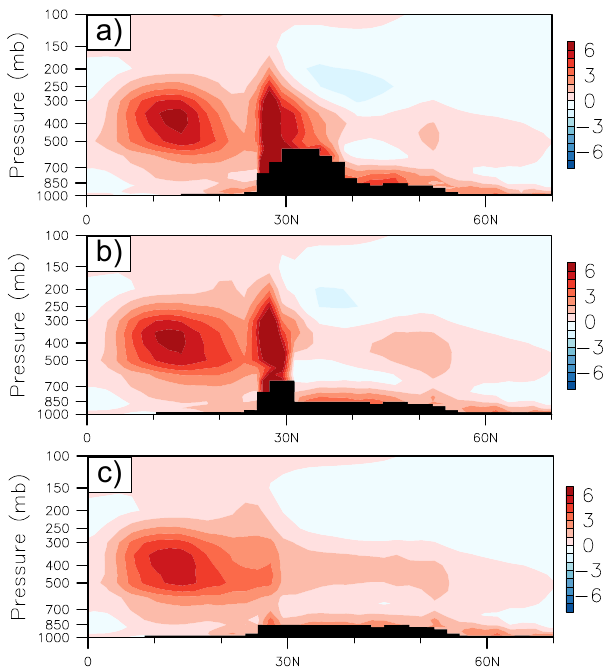
Figure 5. Meridional cross section of Total Diabatic Heating (K/day) averaged between 85-95E for FULL_TP (a), BARRIER (b), and NO_TP (c) experiments, respectively. For all the panels, black shaded region denotes the topography in the experiment.